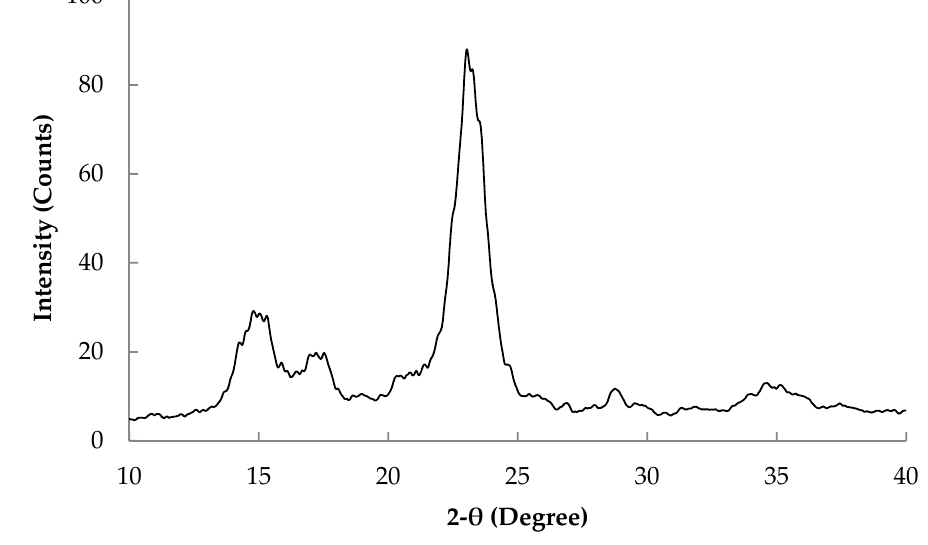
Figure 4. XRD pattern of BC harvested after 2 days.